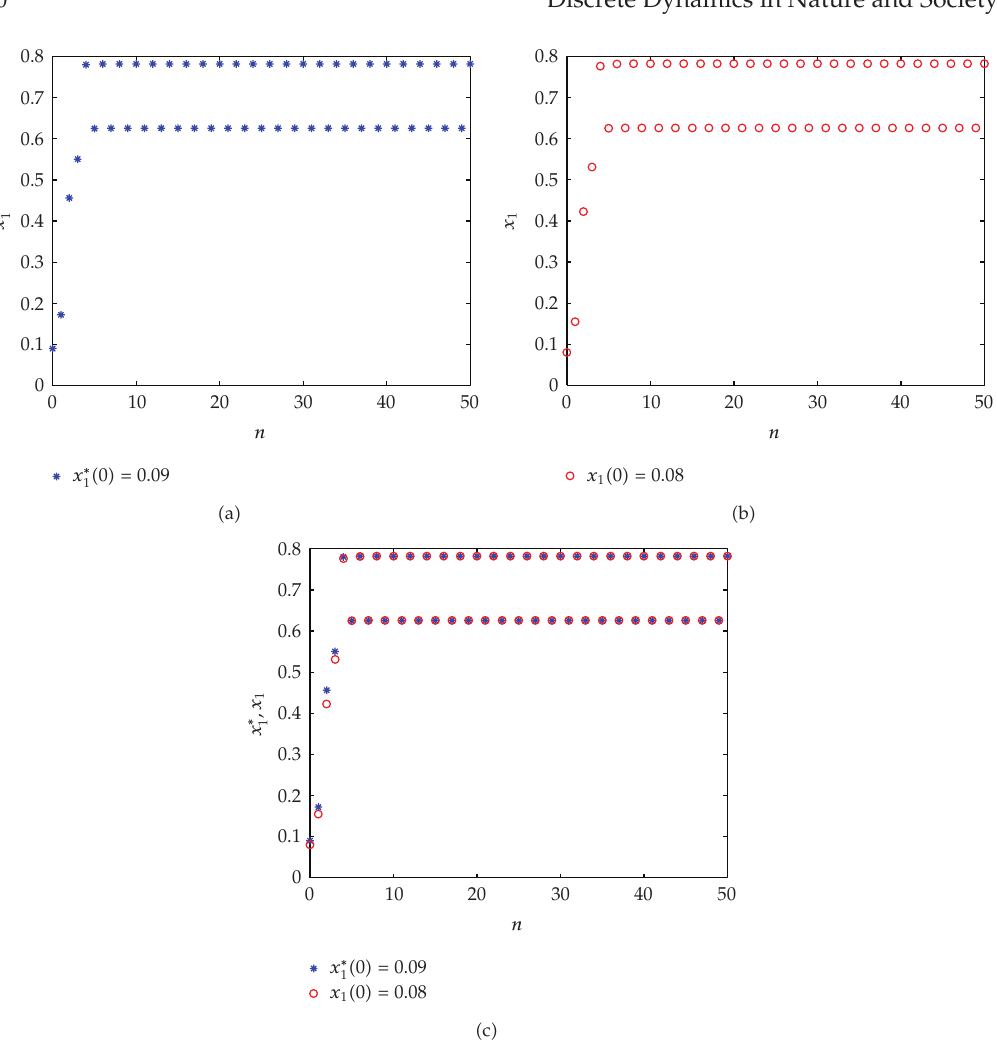
(cid:6) 0 (cid:7) (cid:8) 0 . 08 for 1 with x 1